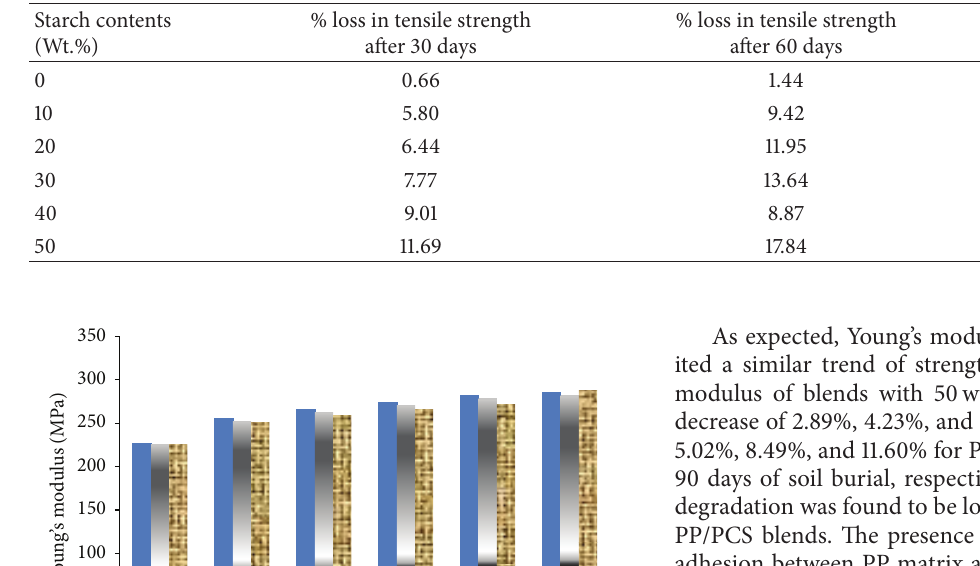
Table 2: Percent decrease in tensile strength of PP/PCCS after biodegradation.